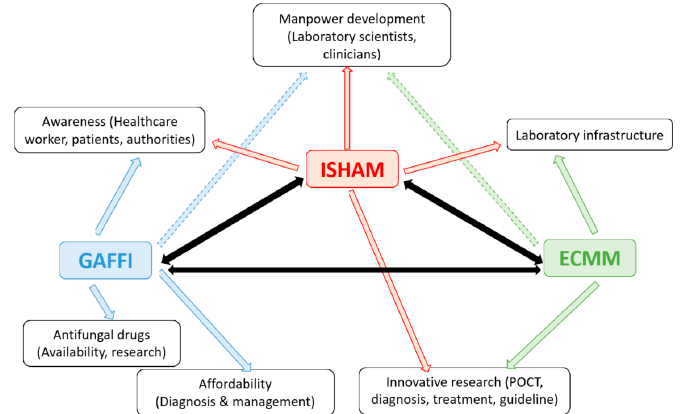
Figure 1. International Society for Human and Animal Mycology (ISHAM)’s close coordination with European Confederation of Medical Myology (ECMM) and Global Action Fund for Fungal Infections (GAFFI). Arrows indicate the activities and influence of different organizations in the indicated fields. Black arrows indicate close coordination of the three organizations.